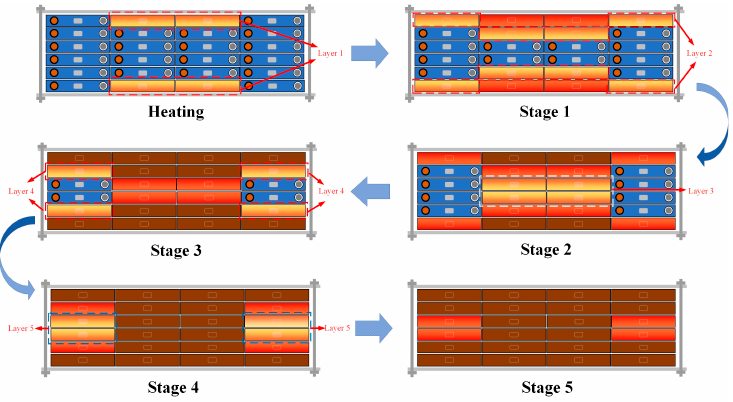
Figure 9. Five stages of LIB pack combustion.